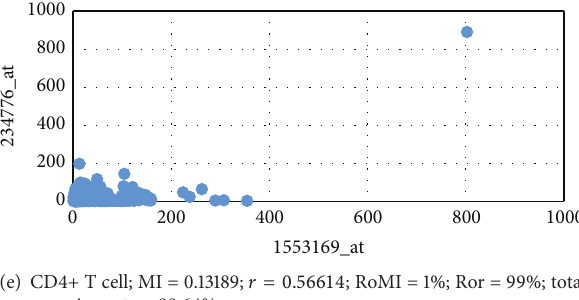
Figure 3: Sample applications for gene coexpression analysis. (a) NME1 and RFC2 in CD4+ T cells. (b) ESRRA and TFAM in DC cells. (c) ZNF232 and GIMAP1 in CD4+ T cells. (d) PTPN21 and ASCC1 in CD4+ T cells. (e) LRRN4 and DMBX1 in CD4+ T cells.